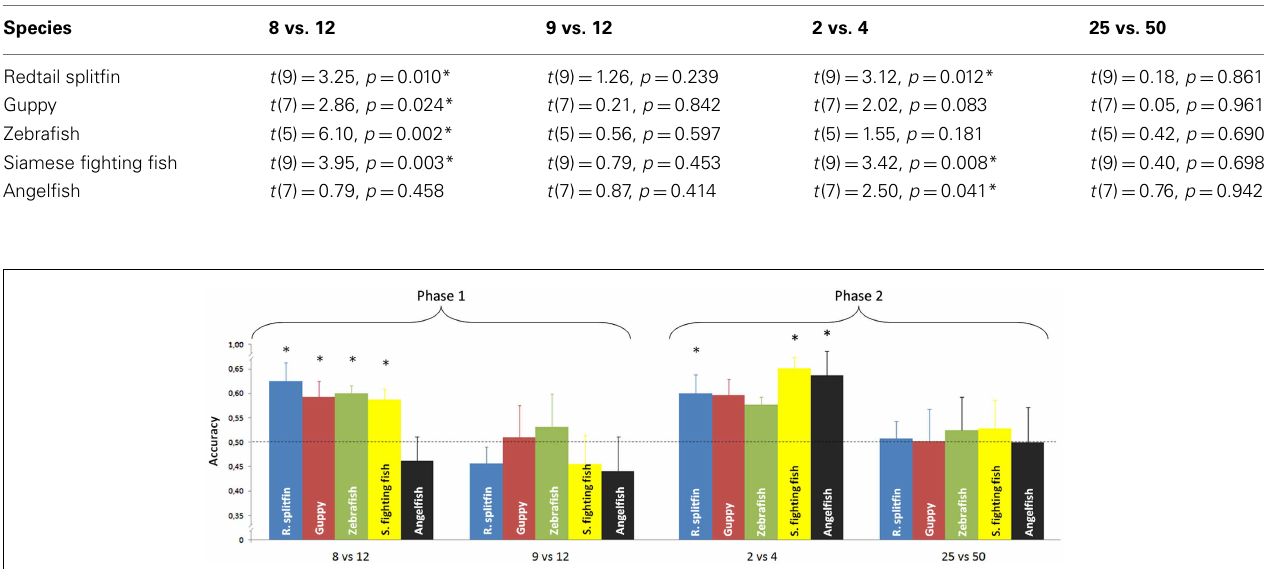
FIGURE 3 | Numerical contrasts were plotted against the accuracy of the five species. Most of the species significantly discriminated 8 vs. 12 and spontaneously generalized to smaller numerosities (2 vs. 4). All species failed